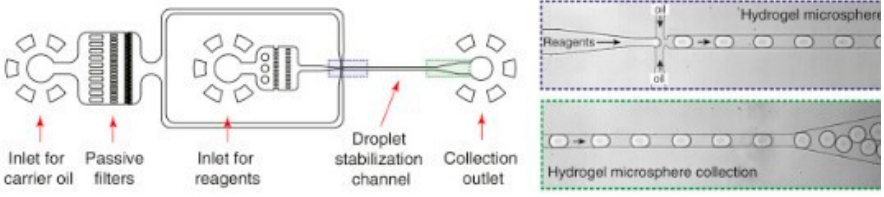
Figure 7. The microfluidic platform utilized in [33] encapsulates cells into droplets with lysis buffer for cell lysis.